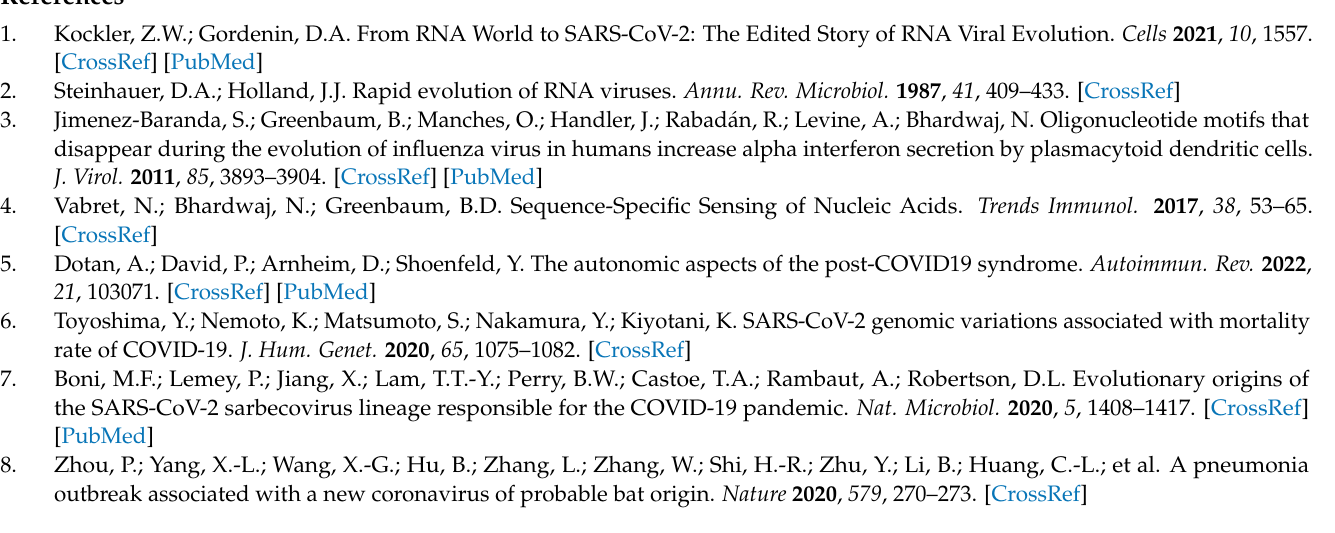
Table S2: Average Percentage of AT and GC across sample cohort; Table S3: List of mutations across lineages and clinical outcomes; Table S4: Statistical significance of lineages and outcomes; Table S5: RNA Secondary Structure prediction; Table S6: Protein quality check; Table S7: Recombination analysis: Table S8: Metadata for sample cohort; Table S9: Average Percentage of AT and GC across USA and India (non-IGIB) sample cohort; Tables S10a–d: List of mutations and normalized